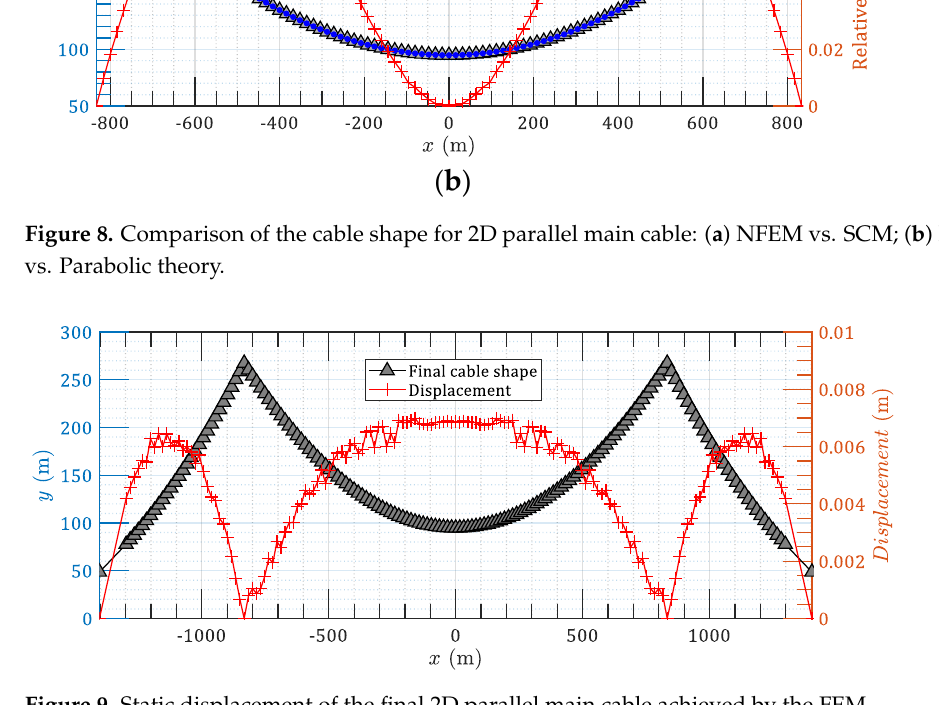
of the z (cid:48) 2 in Equations (9) and (10) is insignificant. This can also be demonstrated from the final main shape in Figure 12. The calculated maximum y (cid:48) 2 and z (cid:48) 2 using the central difference method are 0.2593 and 0.0033,